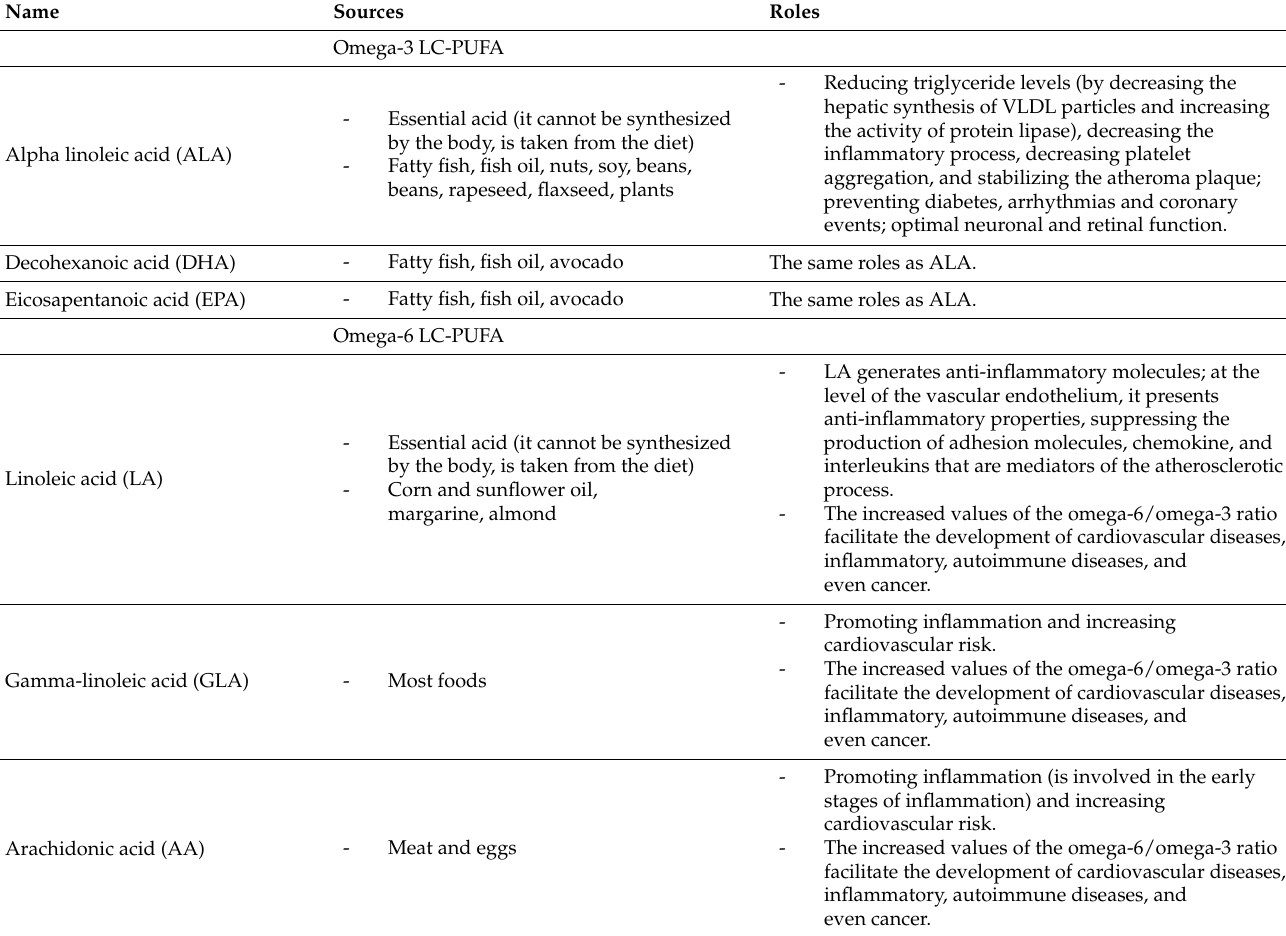
Table 4. Classification, sources, and roles of LC-PUFA